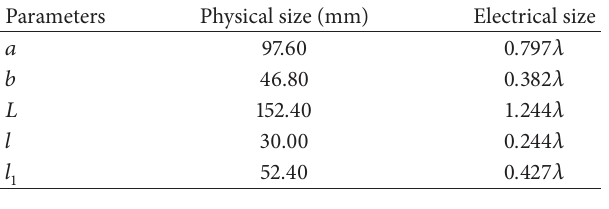
Figure 3: The simulated electric field distributions at the center of the width ( 𝑎 ) side of the antenna without parasitic coupling apertures at 2.45 GHz (side view).